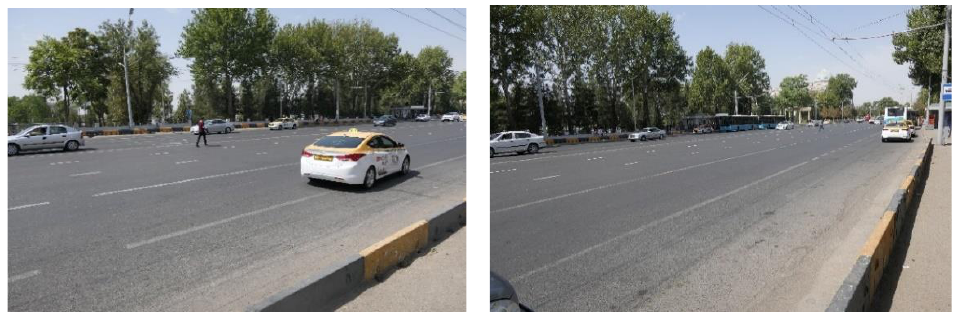
Figure 1. Pedestrians attempting to cross busy, multilane arterial roads in downtown Dushanbe (courtesy of the Young Generation of Tajikistan).